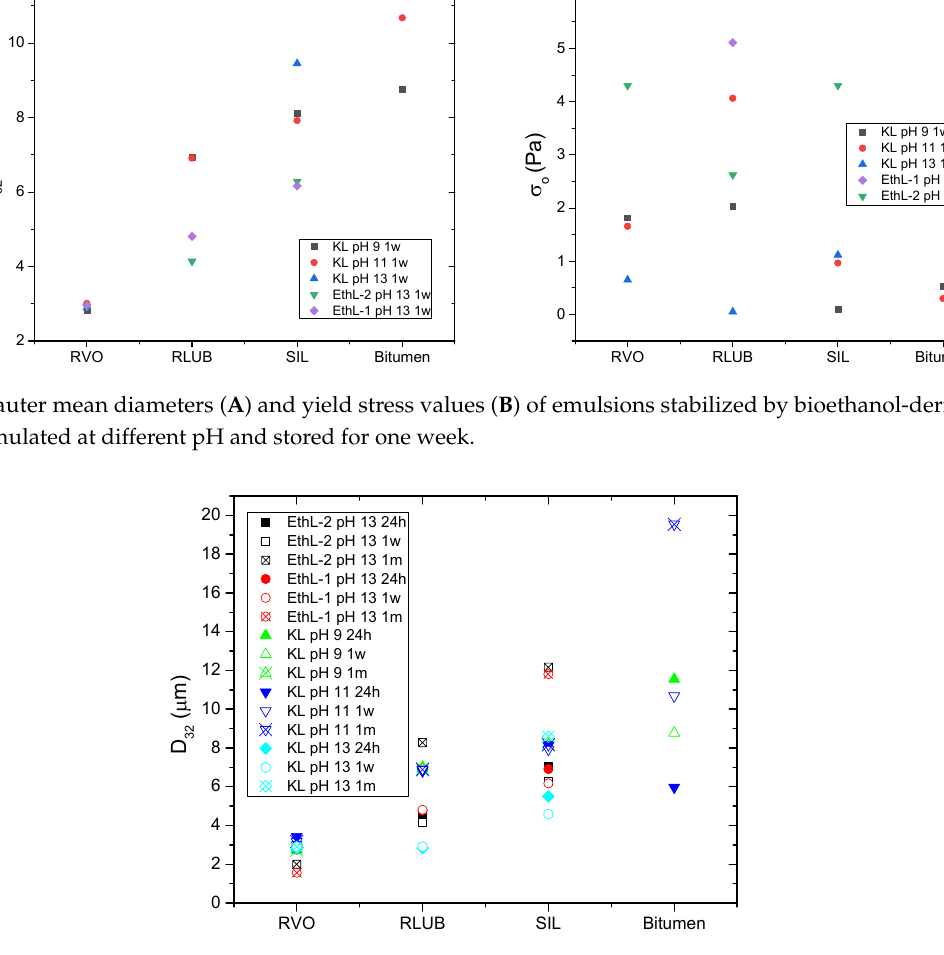
Figure 10. Evolution of emulsion droplet size with storage time as a function of the selected dispersed phase.